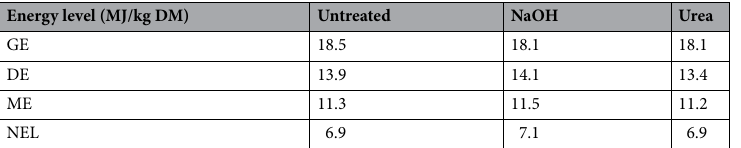
Table 3. Energy concentration of TMR composed of 33.5% maize silage, 21.6% rapeseed meal, 26.7% barley grains, and 18.2% of untreated straw, NaOH treated straw, or urea treated straw on DM basis. The straw treatments are specified in the text. GE was determined by bomb calorimetry, DE was calculated on the basis of GE digestibility determined in the digestibility trial, ME was calculated on the basis of crude nutrient digestibility determined in the digestibility trial, and NEL was calculated on the basis of GE and ME according to GfE 29 . DE, digestible energy; DM, dry matter; GE, gross energy; ME, metabolizable energy; NEL, net energy lactation; TMR, total mixed